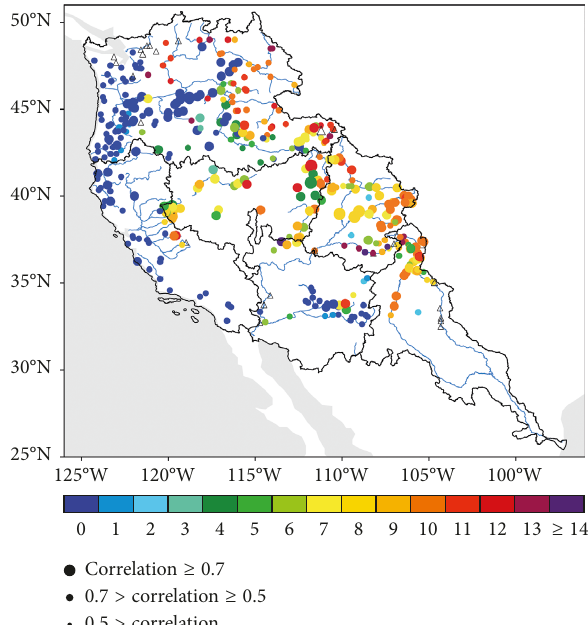
Figure 7: Distribution of the peak lead time and correlation co- efficient between the snow anomaly and streamflow anomaly (unit: pentad). Hollow triangles represent stations that did not pass the 95% significance